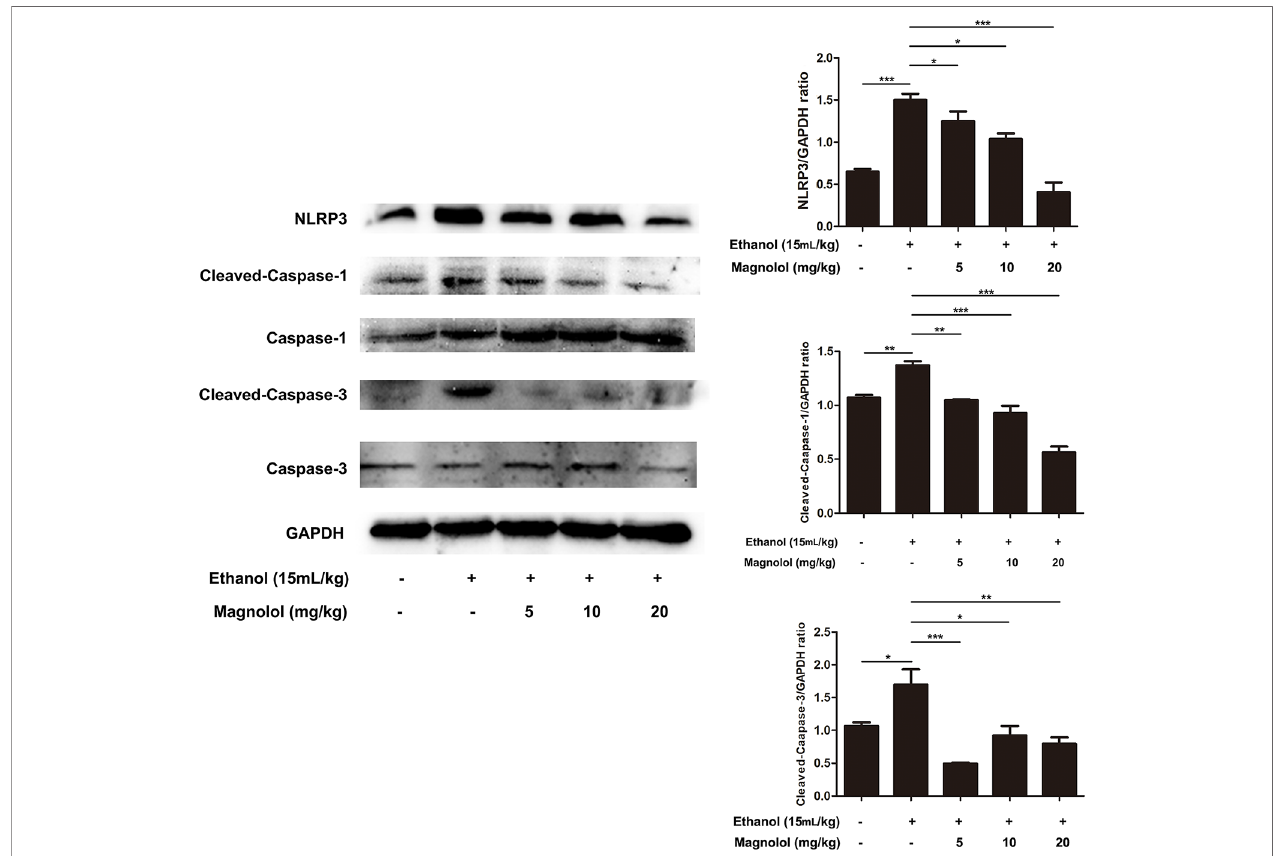
FIGURE 10 | Effects of magnolol on NLRP3 in fl ammasome, caspase-1 and caspase-3 signaling pathway in ALD mice. Magnolol was given to mice for three times, and then alcohol was gavaged. The level of NLRP3 in fl ammasome, caspase-1 and caspase-3 was detected by western blotting analysis with the compared with the internal control (GAPDH). The data is presented as mean ± SD. (*P < 0.05, **P < 0.01, ***P <